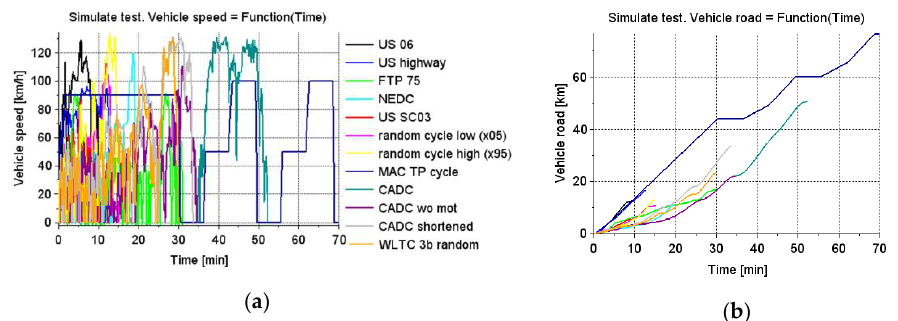
Figure 7. Results obtained in the simulation of selected road tests for the 2013 Mercedes E350 vehicle: ( a ) Waveforms of the instantaneous vehicle speed values; ( b ) Waveforms of the instantaneous values of the distance travelled by the vehicle.